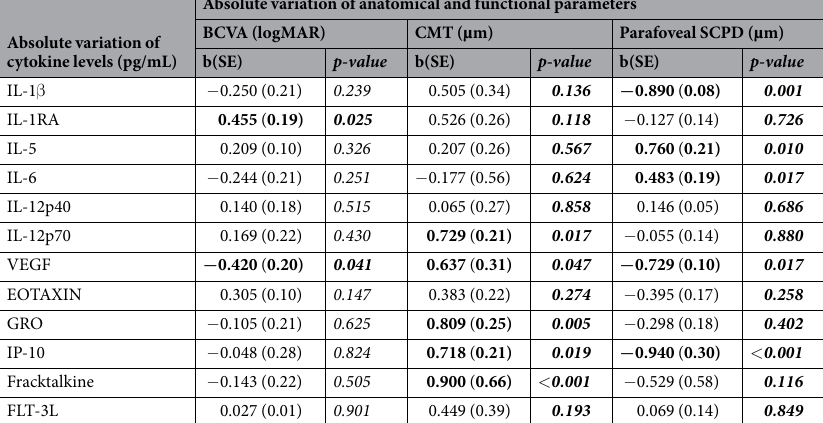
Table 4. Univariate linear mixed model analyses between the absolute variation of aqueous cytokines levels and anatomical and functional parameters. Abbreviations: BCVA = best corrected visual acuity, CMT = central macular thickness; SCPD = superior capillary plexus density; b = regression coefficient adjusted for age, gender and duration of diabetes; SE = standard error. Bolded p-value were significant after FDR